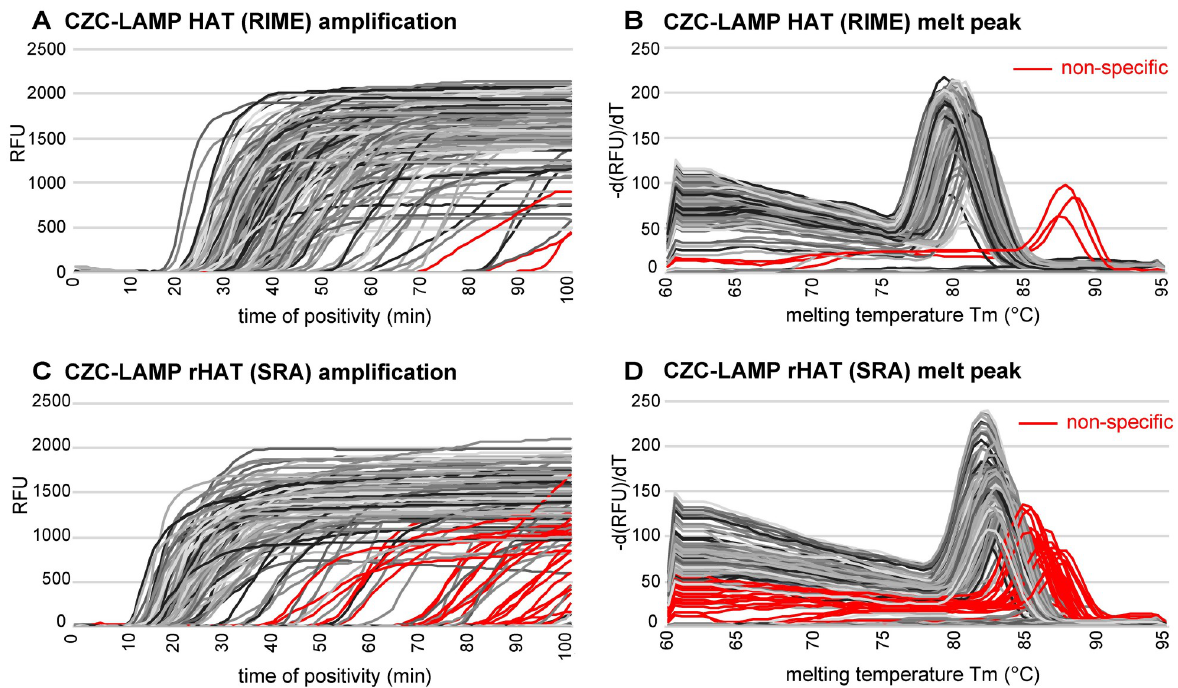
Fig 2. Amplification and melting curves of CZC-LAMP HAT (RIME) and CZC-LAMP rHAT (SRA). A) Real-time amplification fluorescence signal of 214 tests of CZC-LAMP HAT. B) Melting curves of CZC-LAMP HAT products. The curves showed melting temperature (Tm) of 80.0 ± 0.61 ˚C (average ± 2SD, calculated with 100, 10 eq. test results). C) Real-time amplification fluorescence signal of 214 tests of CZC-LAMP rHAT. D) Melting curves of CZC-LAMP rHAT products. The average melting temperature (Tm) was 82.9 ± 0.68 ˚C (average ± 2SD, calculated with 1000, 100 eq. test results). Red colors show out of range results, suggesting non-specific amplification.